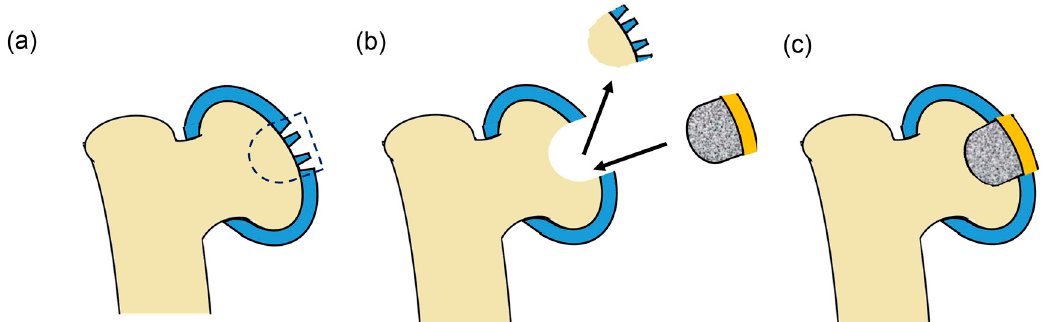
Figure 5. Partially interpenetrated porous implant as a replacement for the damaged cartilage area to ensure the hydrogel is secured while encouraging bone growth within the implant. This would entail ( a , b ) the removal of the damaged cartilage; ( b , c ) and the insertion of the replacement implant with the infused replacement cartilage.